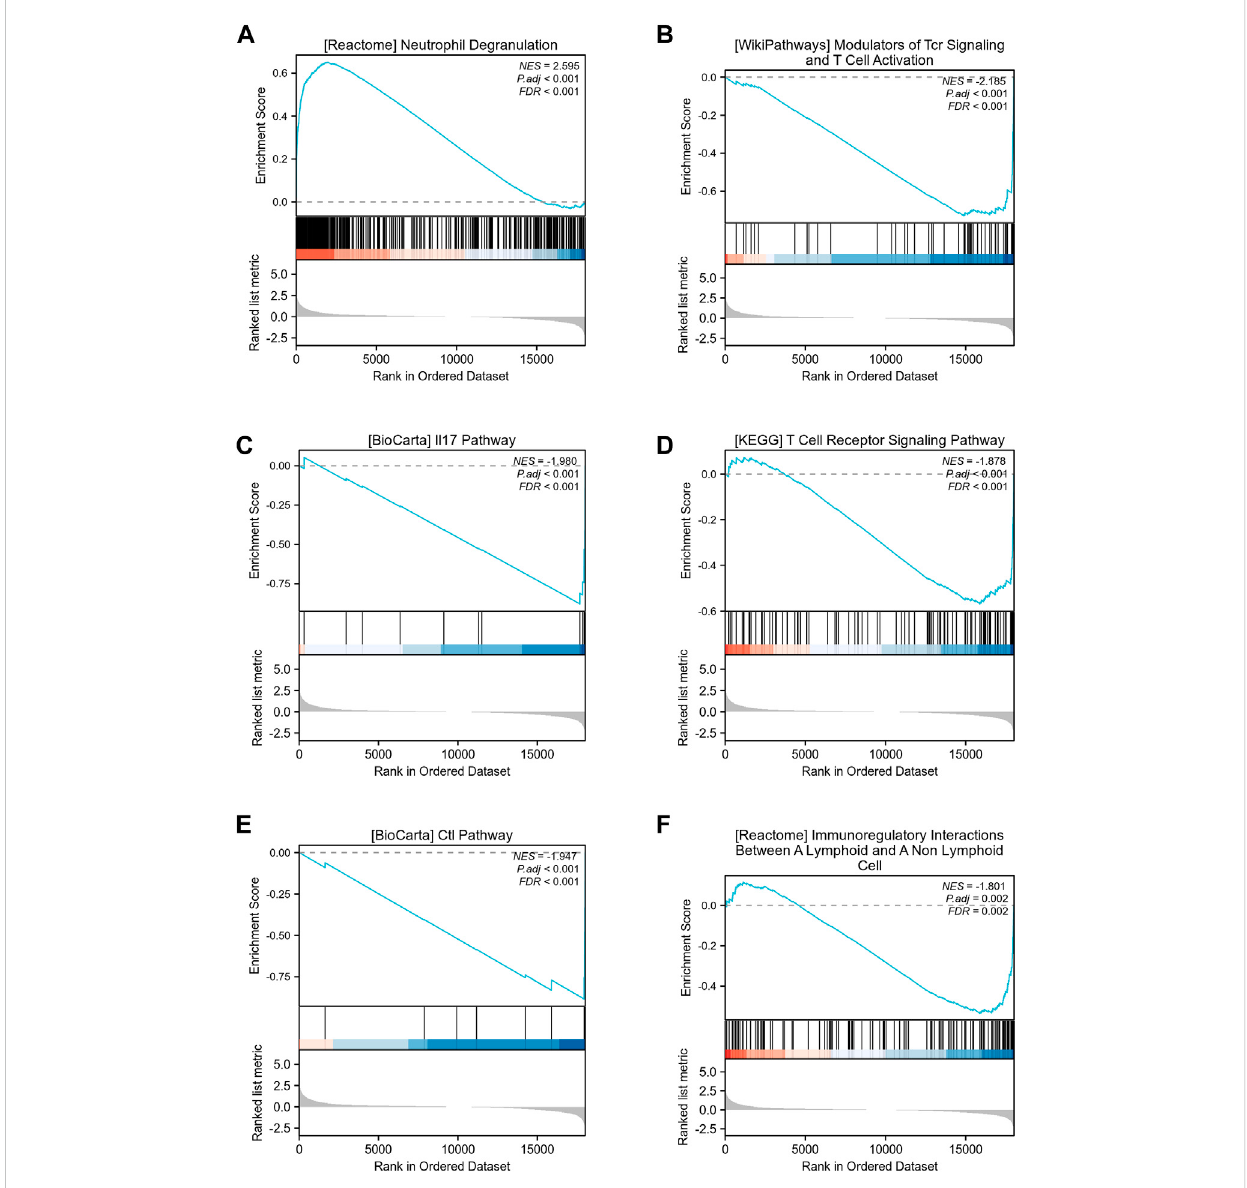
FIGURE 3 GSEA enrichment analysis of GSE28750 dataset. (A) GSEA enrichment analysis of data sets in Neutrophil Degranulation. (B) GSEA enrichment analysis of data sets in Modulators of Tcr Signaling and T Cell Activation. (C) GSEA enrichment analysis of data sets in IL 17 Pathway. (D) GSEA enrichment analysis of data sets in T Cell Receptor Signaling Pathway. (E) GSEA enrichment analysis of data sets in Ctl Pathway. (F) GSEA enrichment analysis of data sets in Immunoregulatory Interactions Between A Lymphoid and A Non-Lymphoid